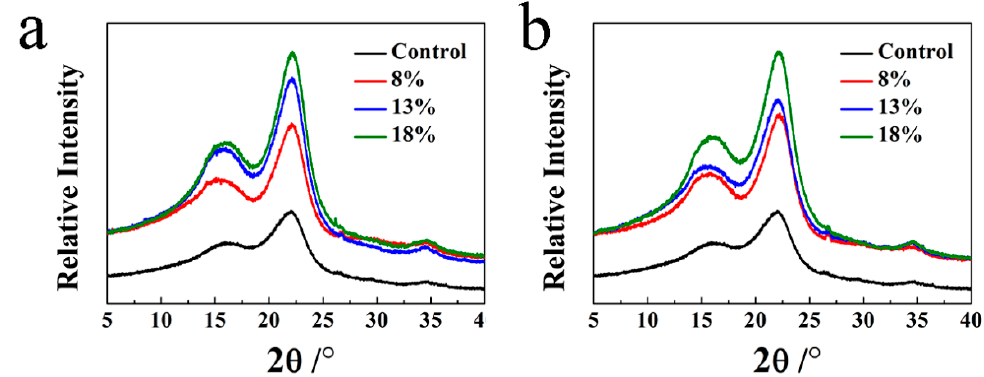
Figure 7. X-ray diffraction (XRD) patterns of healthy (control) and decayed OWMEC samples with different resin contents: ( a ): T. versicolor decay; ( b ): G. trabeum decay.